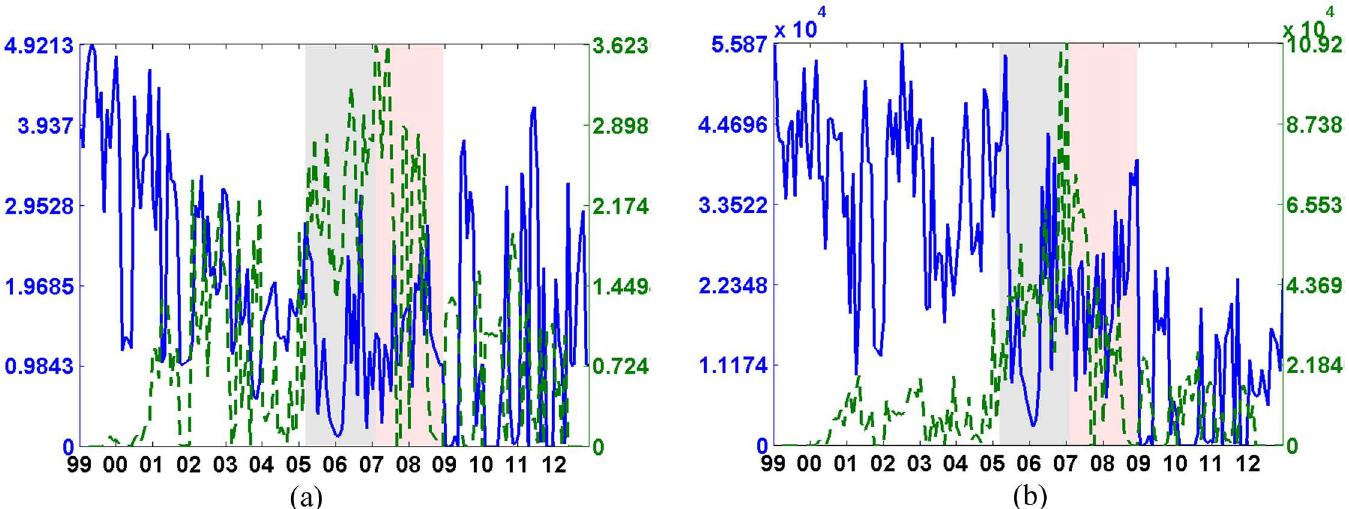
Fig 1. Time evolution of the borrowing (a) and lending (b) score for rank-1 NMF from 1999 to 2012 at a monthly frequency. The solid blue line refers to the sum of Italian banks’ scores whilethe dashed green line is associatedto the sum of foreign banks’ scores. The gray shaded area emphasizes the pre- crisis period (2005-Q1:2007-Q1)while the red area indicatesthe crisis period(2007Q1:2008-Q4). The x-axis in both subplotsrefers to years whilethe left y- labels report the sum of the borrowing (a) and lending(b) scores for Italian banks, the right y-labels are associatedto magnitude of the score of the foreign